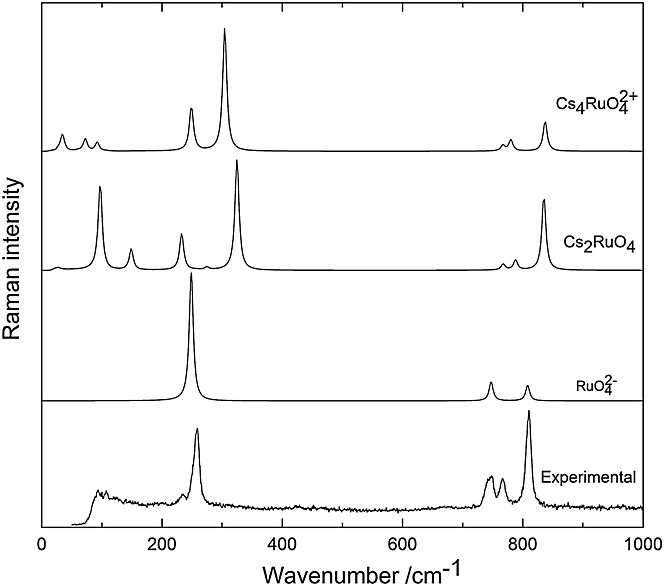
Comparison of the experimental Raman spectrum of solid Cs2RuO4 (bottom) with the calculated ones of the models RuO42−, Cs2RuO4, and Cs4RuO42+.